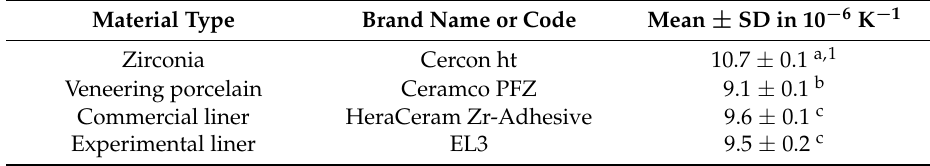
Table 3. Coefficient of linear thermal expansion of the four ceramic materials used ( n = 5).